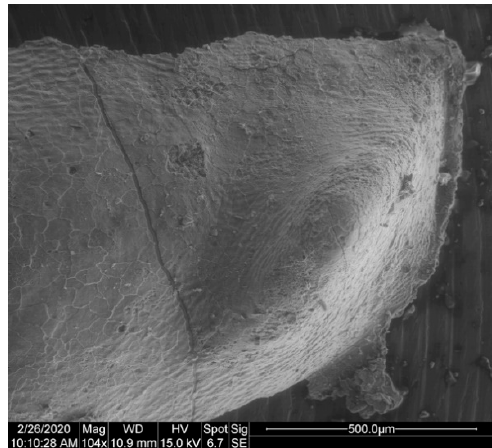
Figure 31. Cambroarchilocus tigris gen. nov. sp. nov. Holotype. Left shield, anterior to left. IGM 3614 (42). Photo Credit: Mark McMenamin.